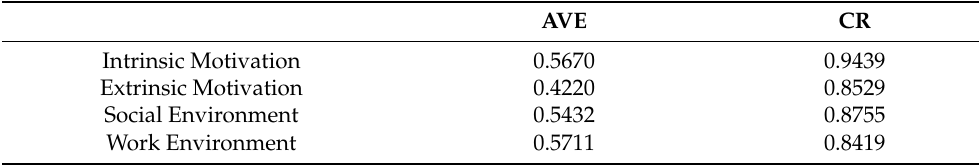
Table 5. The composite reliability and average variance extracted of the four factors.